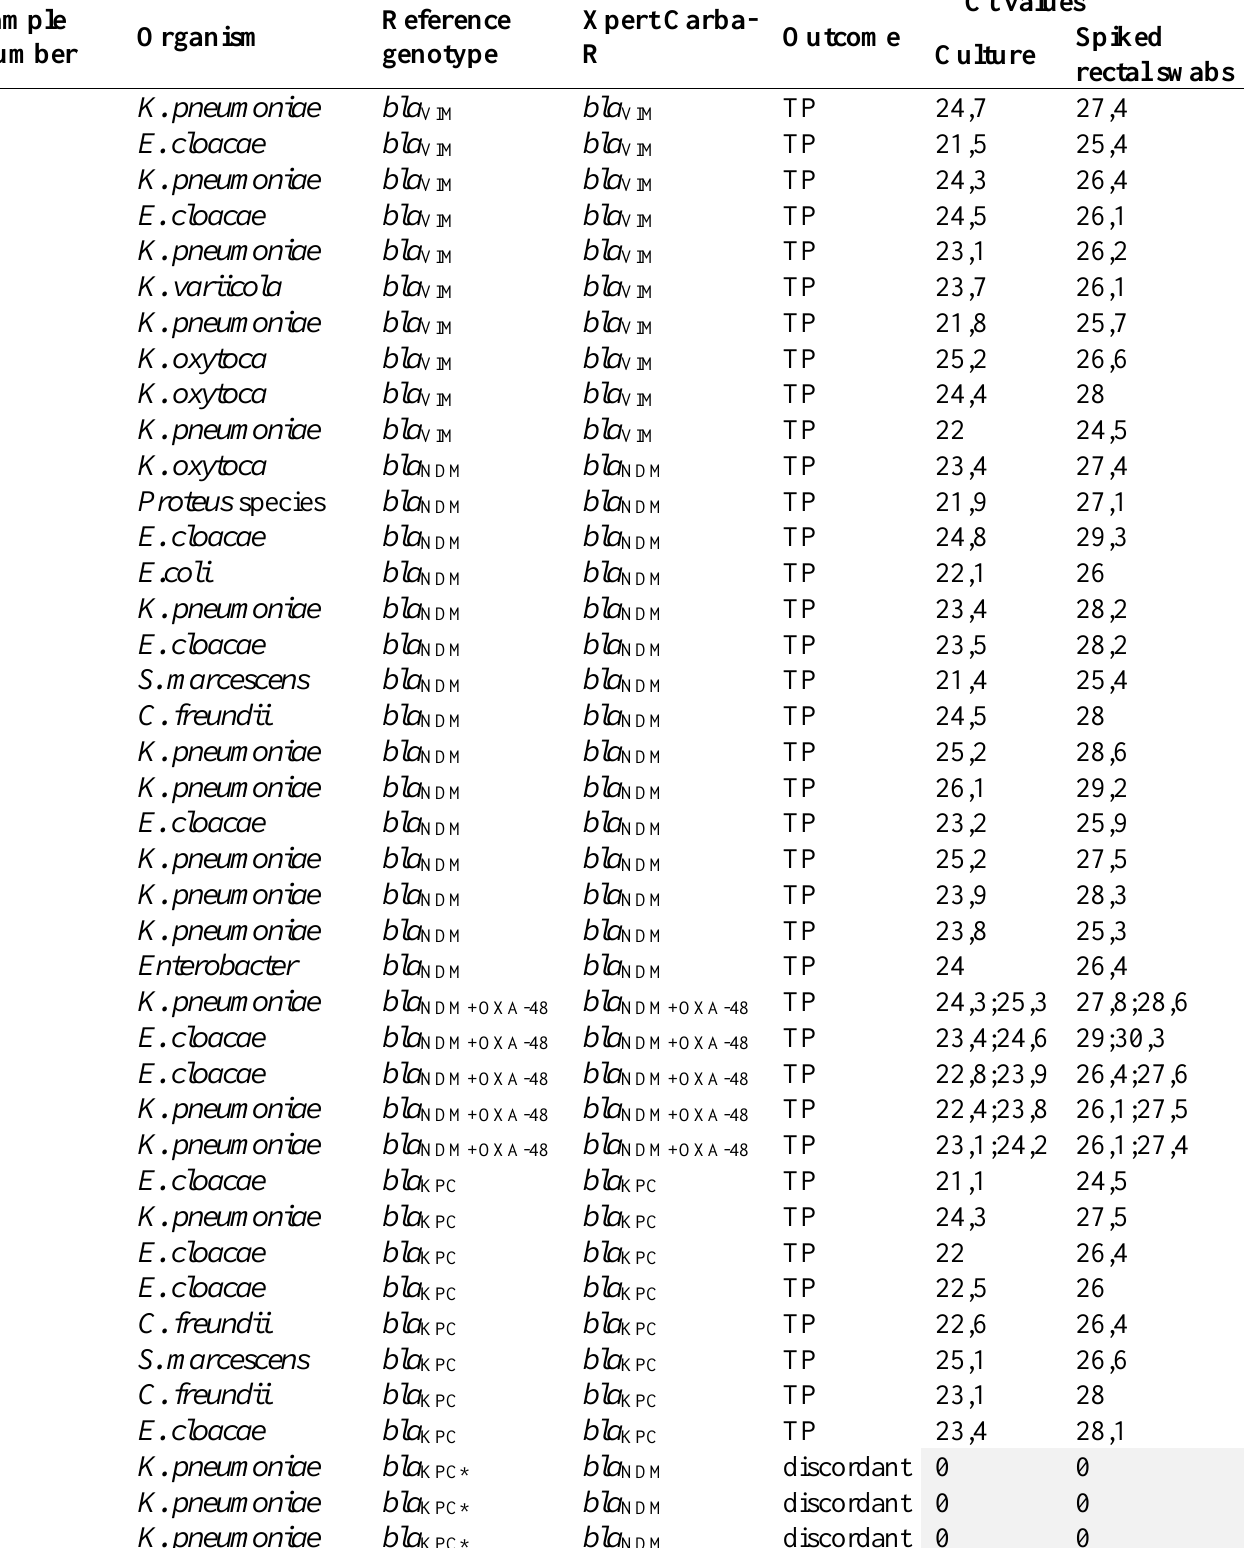
Supplementary Table 1: Xpert Carba-R assay results for cultured bacterial isolates and spiked rectal swabs at the Infection Control Laboratory Services in Johannesburg, South Africa between April-September 2021. Reference genotypes were previously determined using Resist-4 O.K.N.V and/or Light Mix multiplex PCR carbapenemase